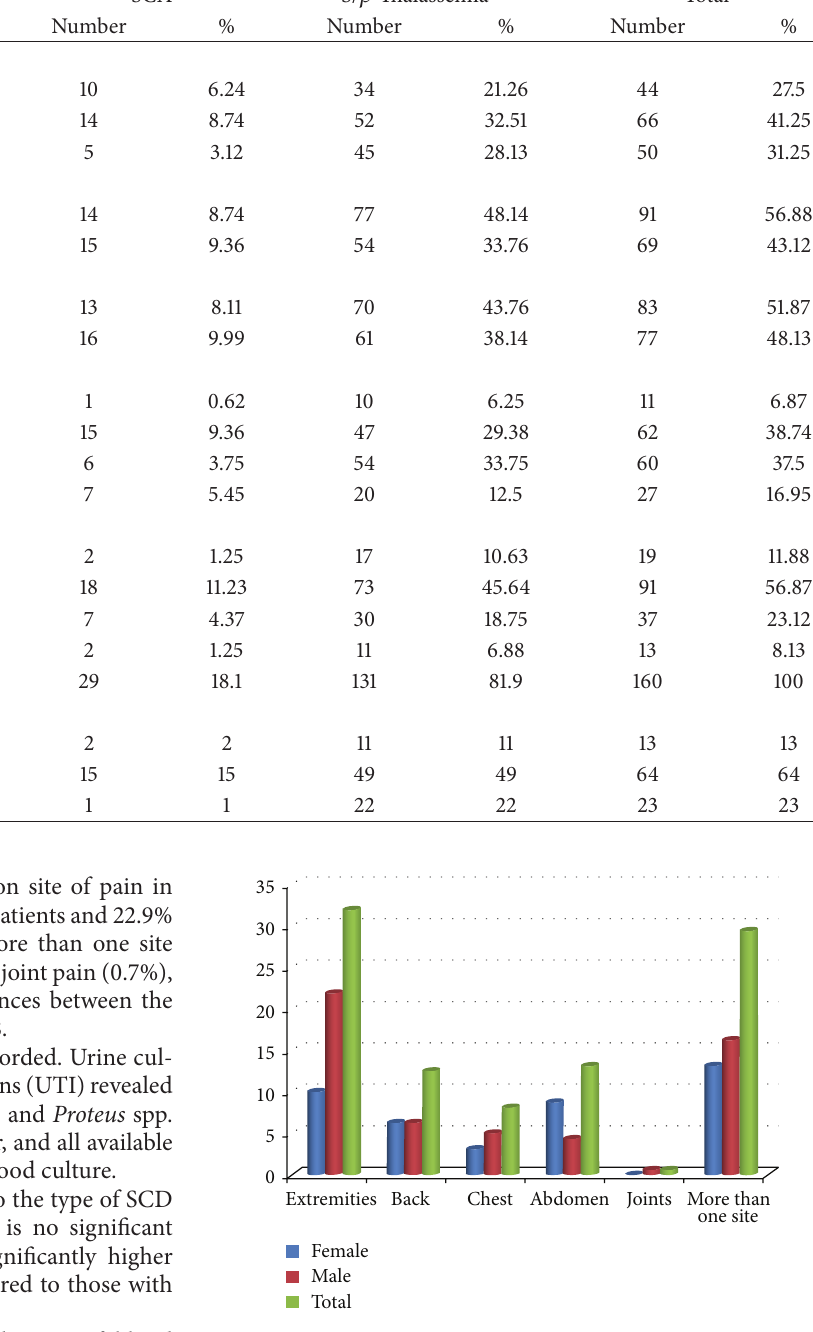
Figure 1: Frequency of sickle cell pain by body region and sex. 𝑃 value = 0.178 (chi-square